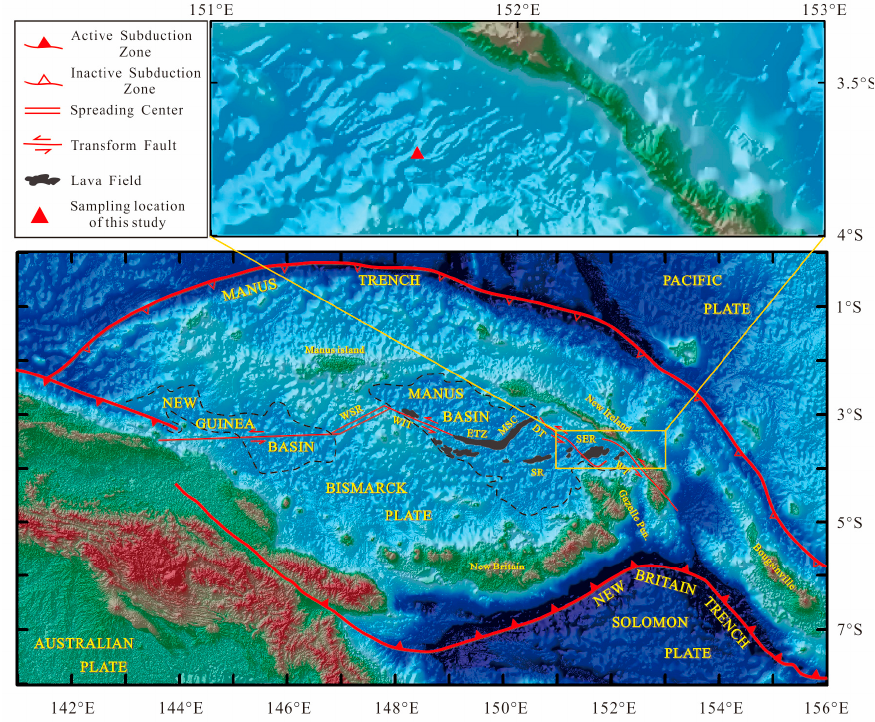
Figure 1. Regional geologic map of the Manus Basin, western Pacific (base map database from https://www.gebco.net/data_and_products/gridded_bathymetry_data/ (accessed on 28 February 2022); modified from ref.